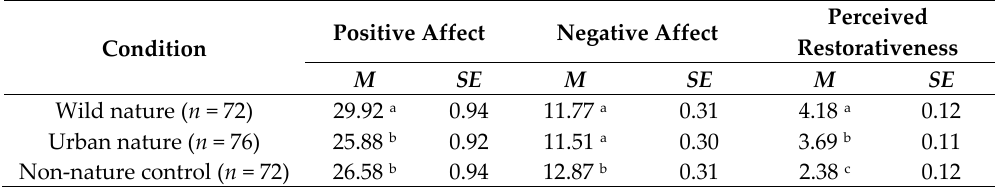
Table 2. Covariate-adjusted means ( M ) and standard errors ( SE ) for key study variables for experimental